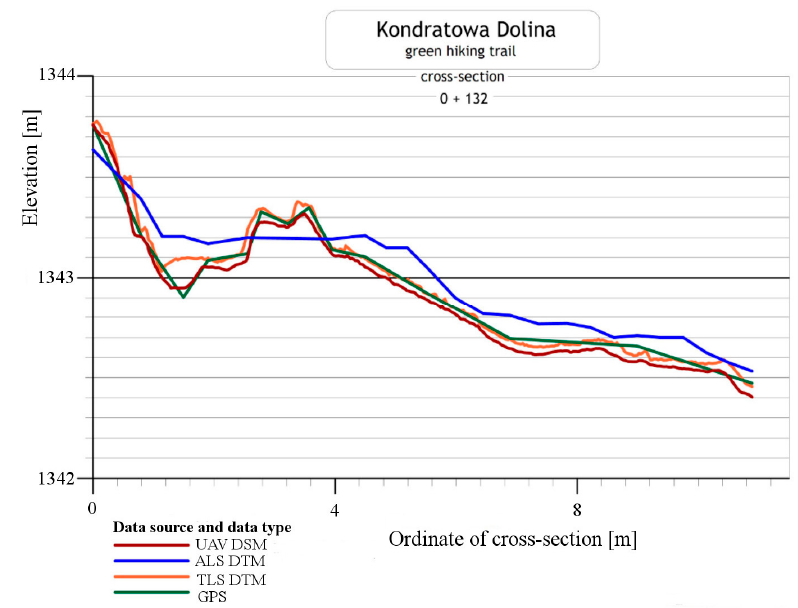
Figure 12. Example of the cross-section of the hiking trails determined with different survey methods (UAV, ALS, TLS, GPS) (source: authors’ own study).